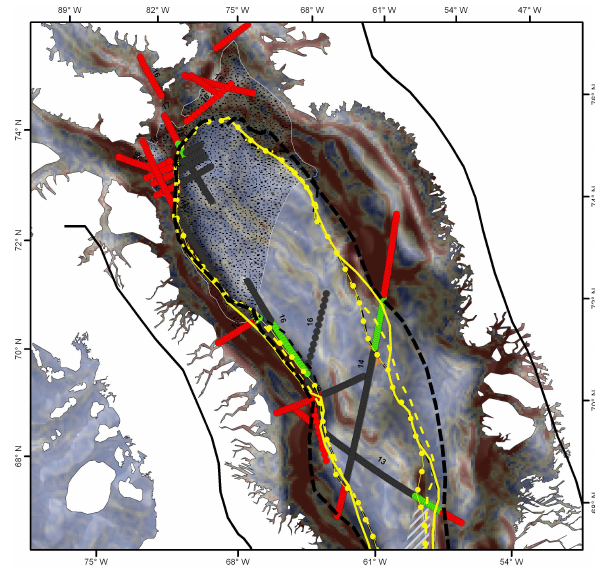
Fig. 4. Interpreted crustal structure and alternative COB models in Baffin Bay. Key is the same as for Fig.